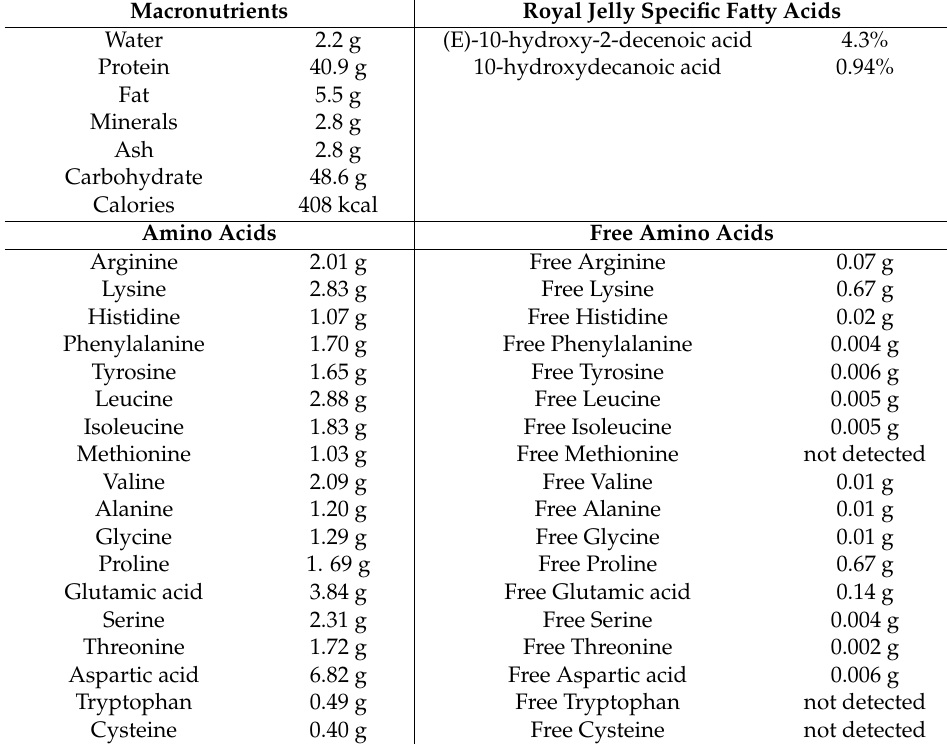
Table 1. Composition of the freeze-dried royal jelly powder (per 100